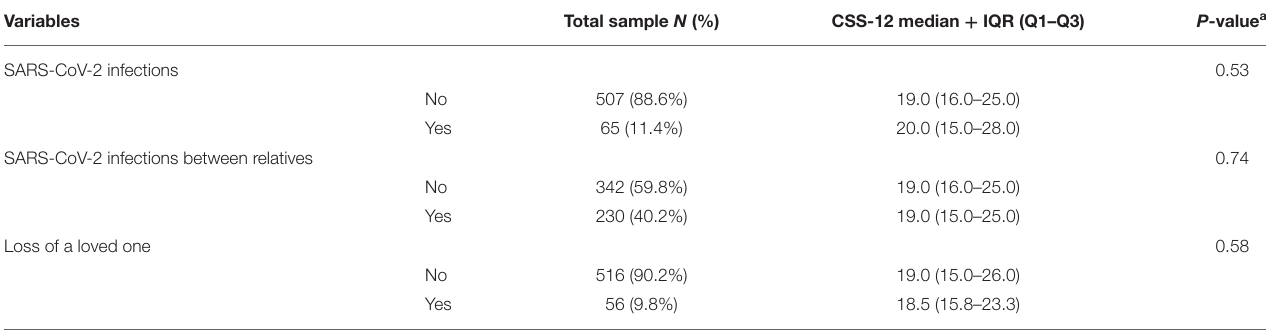
TABLE 2 | Variables related to COVID-19 and associated scores on the Cyberchondria Severity Scale (CSS-12).